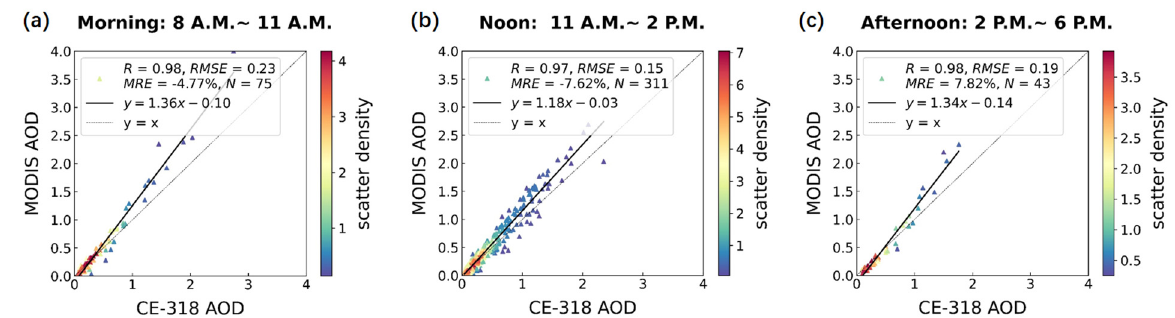
Figure 4. AHI AOD inversions were evaluated at different times of the morning ( a ), noon ( b ), and afternoon ( c ) using the Gucheng sun photometer AOD as a standard.